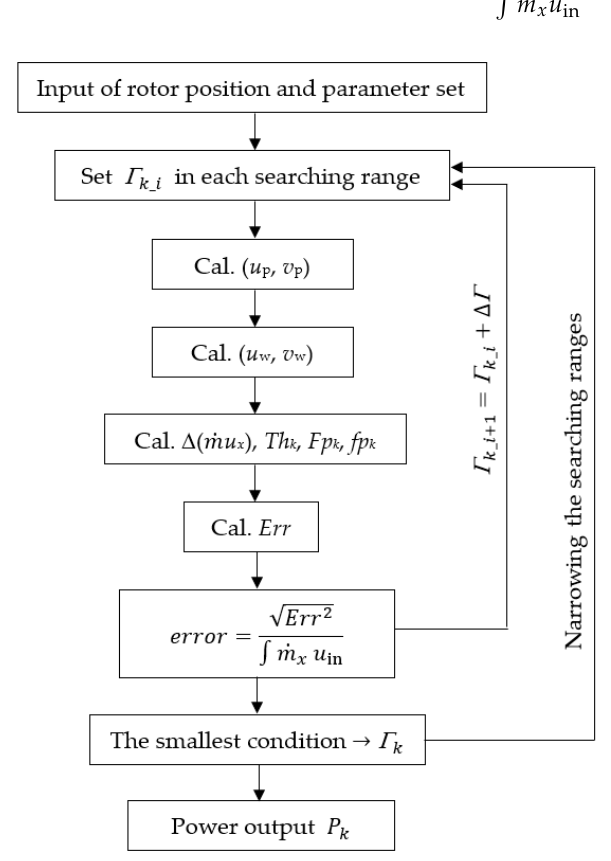
Figure 5. The flow chart of the method.